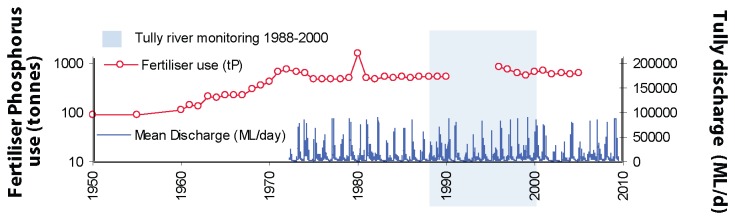
Time series detailing historical fertiliser-P use (tonnes, log scale) in the Tully River catchment 1950-2005 [21,22] and Tully River discharge 1975-2009 (data available: www.derm.qld.gov.au. Accessed 2013, Aug 26).Blue shaded boxes highlight the discrete 13 year period of contemporaneous river monitoring data.